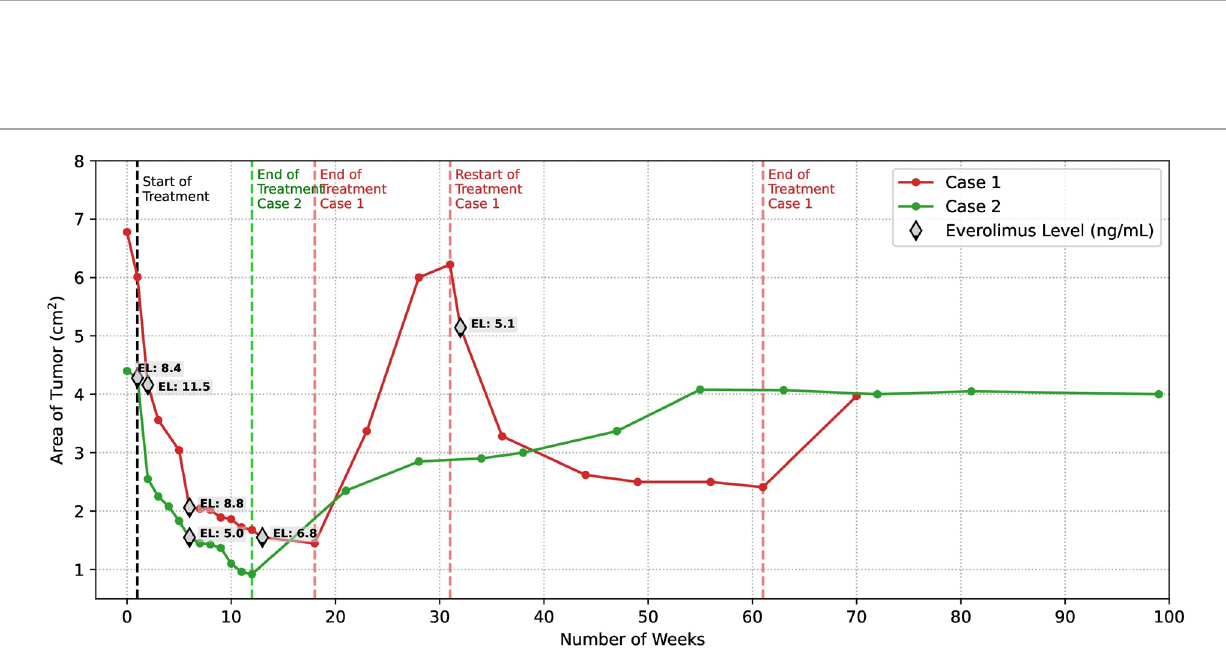
FIGURE 2 Comparative regression in the size of CRHMs after initiation of treatment with low dose everolimus. An accelerated decrease of close to 50% of the initial area of the CRHM is evident in both cases at three weeks of treatment. The maximum reduction in the mass area was reached at 17 weeks of treatment for case 1 and 12 weeks of treatment for case 2, the two of them close to 79%. In both patients, the serum everolimus level was maintained in therapeutic ranges (target through concentrations between 5 and 15 ng/ml). Once treatment was discontinued CRHM experienced rebound growth, being particularly accelerated in case 1. The restart of everolimus in case 1 demonstrated a rapid reduction in mass size. Case 2 CRHM maintained a stable size without signs of hemodynamic repercussions after undergoing rebound